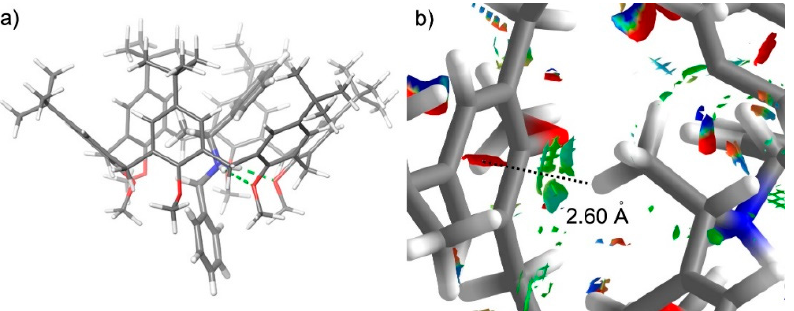
Figure 3. ( a ) DFT-optimized structures of the ( endo-chiral )- 2 + @3 complex at the B3LYP/6-31G(d,p) level of theory. Dashed lines represent H-bonding interactions between ammonium group of 2 + and oxygen atoms of 3 . ( b ) NCI plot by the sign of the second Hessian eigenvalue [gradient isosurfaces (s = 0.6 a.u.) for ( endo-chiral )- 2 + @3 complex. In the coloring isosurface, blue and green colors represent strong and medium interactions (H-bonding and van der Waals). Highlighted the CH 2 ‒ H··· π distance between the methyl group of axle 2 + and an anisole ring of the calix[6]-wheel. Expanding Coefficient (EC, Equation (1)) is defined as the ratio between the final and the initial cavity volumes of the host, i.e., the volume of the host cavity after the complexation ( V complexed_host at the global minimum) and that of the host cavity before the complexation ( V free_host at the global minimum) [38].